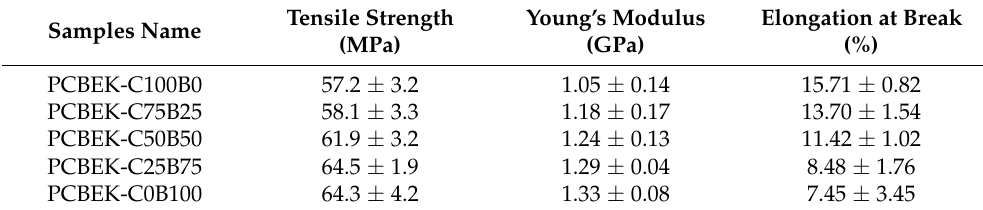
Table 3. Mechanical property parameters of copolymer PCBEKs films.